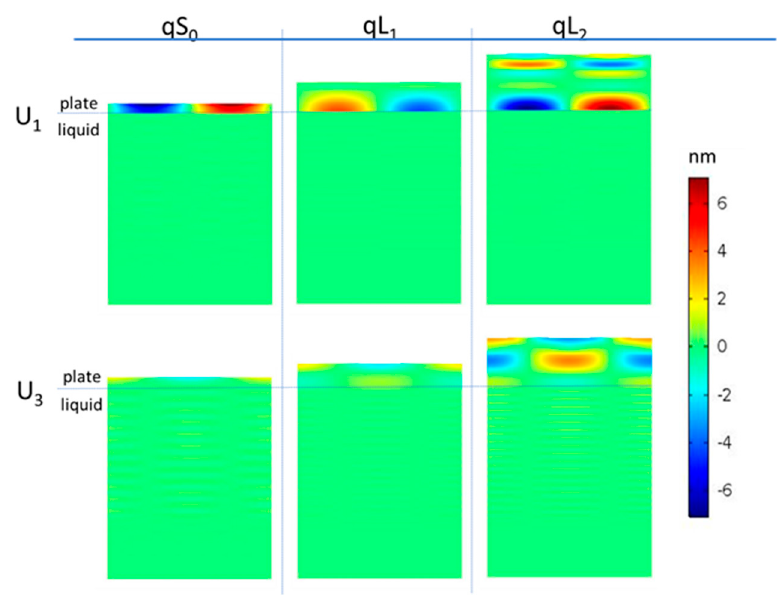
Figure 8. The displacement components U 1 and U 3 of the three modes propagating along the a-SiC/ZnO plate that makes contact with the liquid. The a-Sic and ZnO layers have a thickness equal to 5 and 2.5 µm; the plate width is equal to one λ ; the H/ λ = 0.15, 0.45, and 0.85, for qS 0 , qL 1 , and qL 2 , respectively.